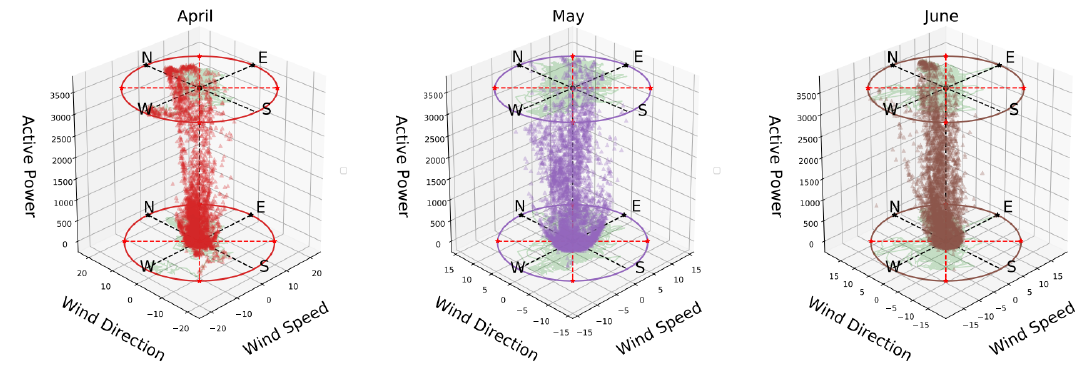
Figure 9. Wind Speed vs. Wind Direction vs. Active Power.